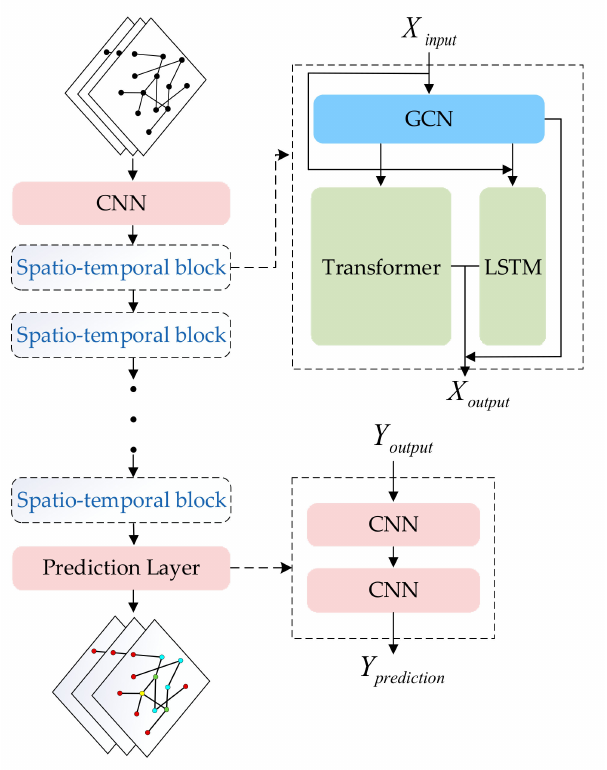
Figure 2. The overall architecture of the model.